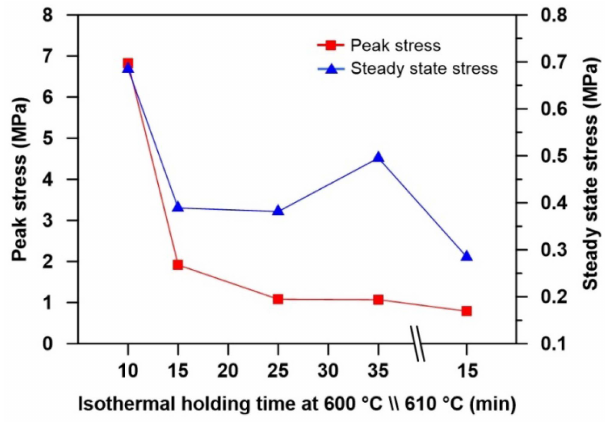
Figure 17. Peak and steady state stresses of the SIMA processed samples with different initial